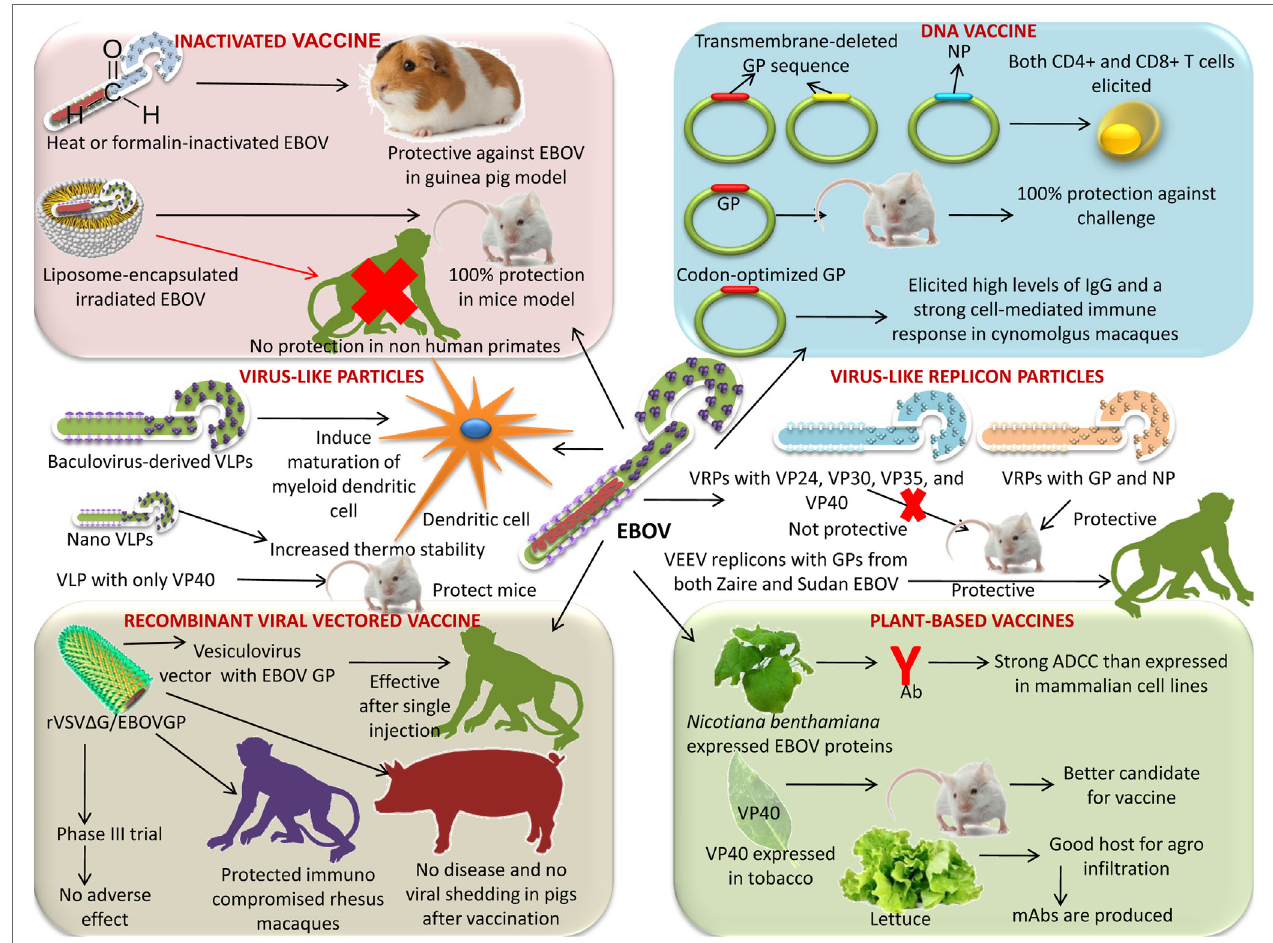
FiGURe 1 | Various vaccine platforms under progress for the development of a successful Ebola virus (EBOV) vaccine. Platforms like inactivated vaccine, DNA vaccine, virus-like particles, virus-like replicon particles (VRPs), plant-based vaccine, and recombinant viral-vectored vaccines are